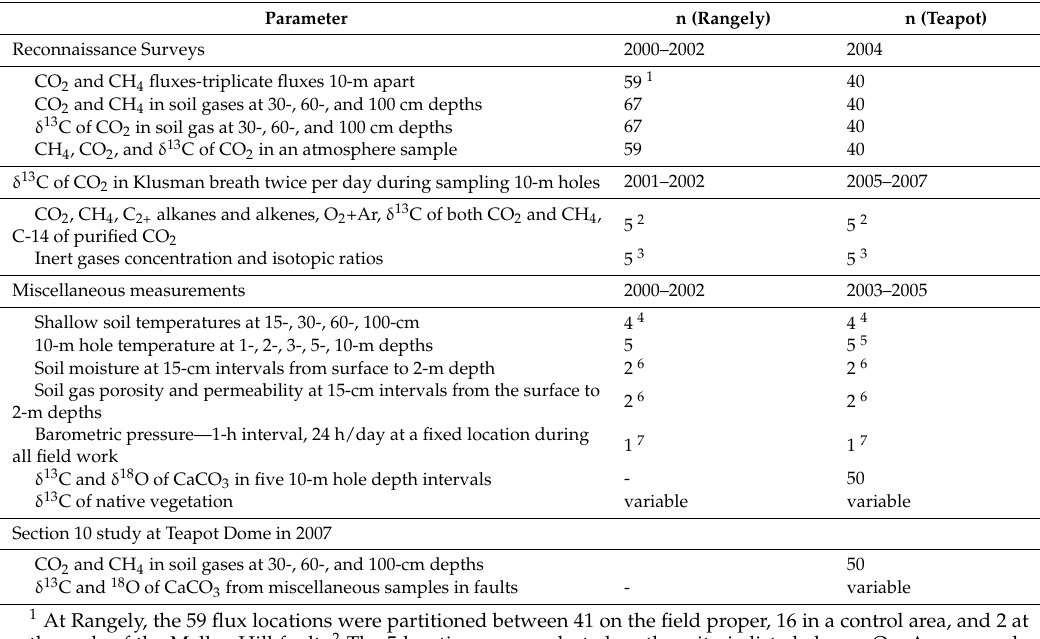
Table 1. Measurements made at Rangely and Teapot